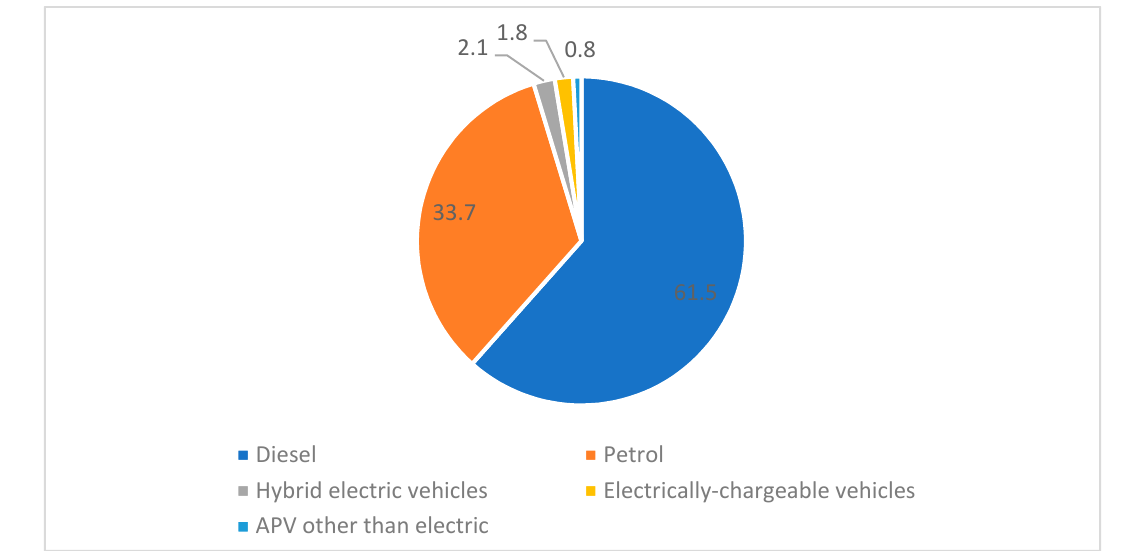
Figure 6. New passenger cars in Portugal by fuel type, 2017, from the European Automobile Manufacturers’ Association (ACEA). As for 2020, in Portugal, there is a small change of course as BEVs account for 5% of car registrations across the country (compared to 1.8 in 2018). Tesla Model 3 was the most registered electric car in the first eight months (Table 4). National car registrations fell by only 0.1% in August. Data from the ACAP (Associaç ã o Autom ó vel de Portugal) reveal a growing in the number of registrations of light vehicles in the country, which in July recorded a drop of 17.8%. Between January and August, the national light vehicle market recorded a decline of 42.0% [26] (Table 5). Table 4. Sales ranking of light passenger electric vehicles in Portugal [25].